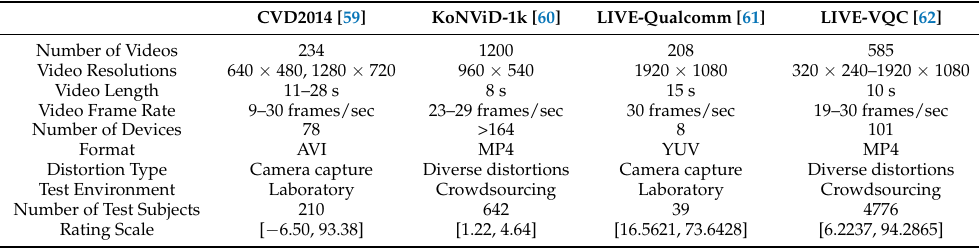
Table 2. Comparison of four video quality benchmark datasets: CVD2014, KoNViD-1K,LIVE- Qualcomm, and